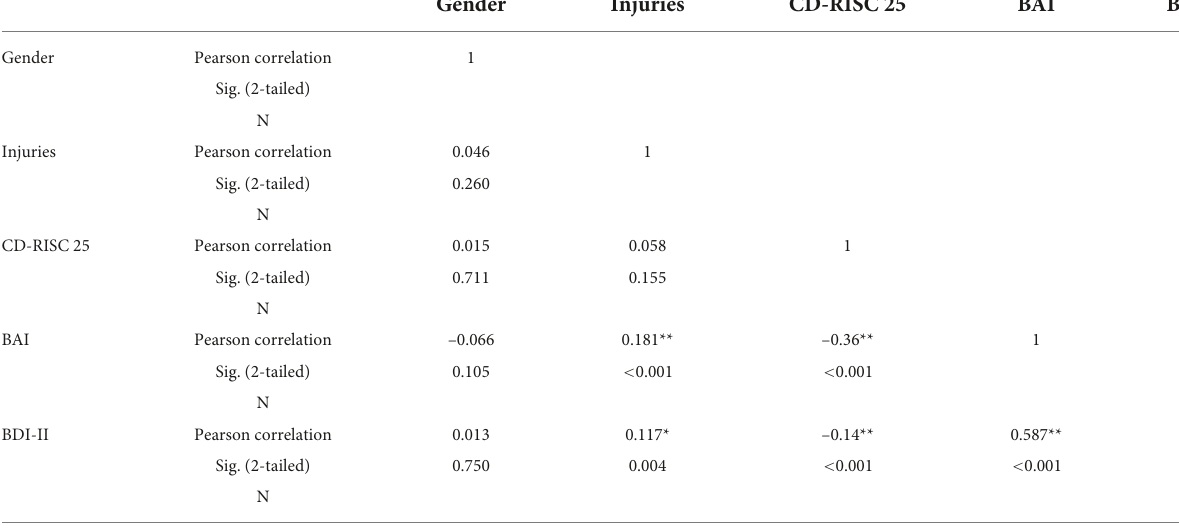
TABLE 2 Pearson correlation matrix.